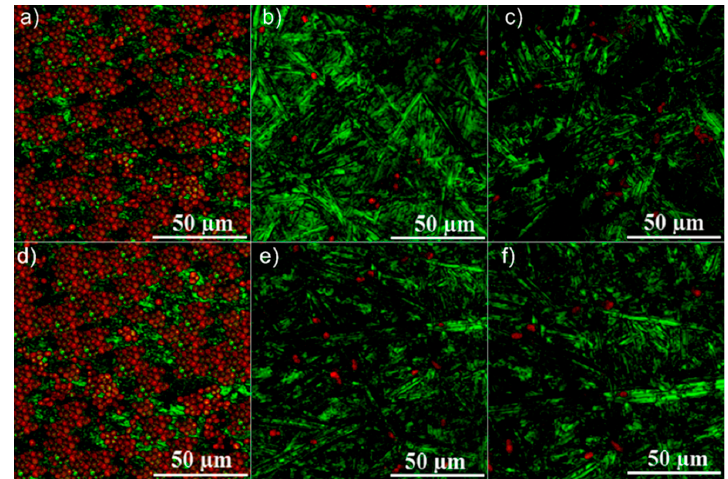
Figure 13. CLSM images of C. albicans ATCC 10231 cell development on Ti discs used as control ( a , d ) and Ag: HAp-S1 and Ag: HAp-S2 composite layers at the two time intervals T0 (Ag:HAp-S1_T0 ( b ) and Ag:HAp-S2_T0 ( c )) and T6 (Ag:HAp-S1_T6 ( e ) and Ag:HAp-S2_T6 ( f )) after 24 h of incubation.